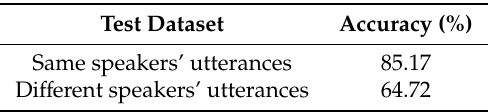
Table 6. Accuracy of the proposed method when trained and tested with the public dataset comprising four di ff erent rooms